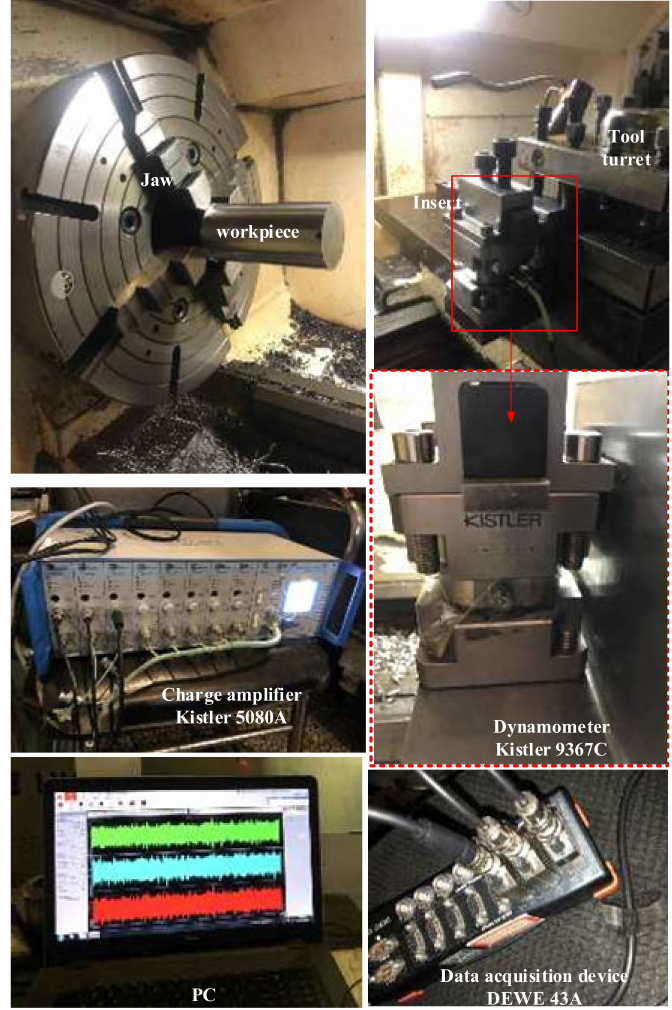
Figure 12. Photograph of the experimental